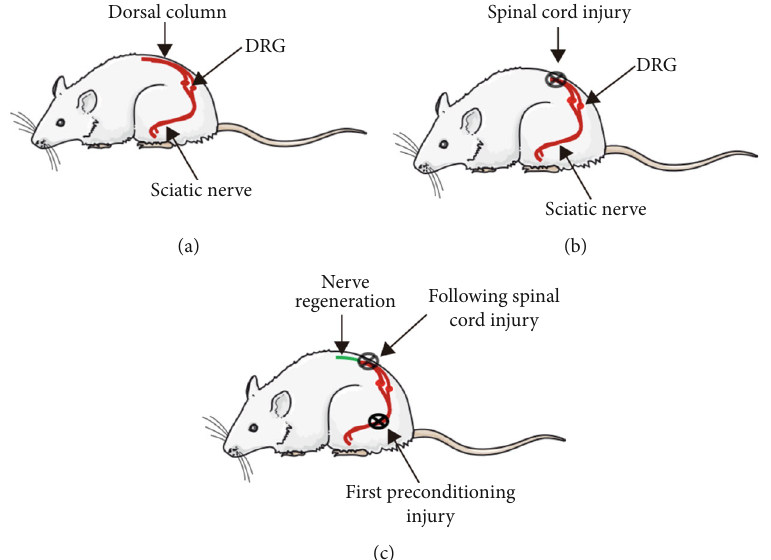
Figure 1: Preconditioning injury paradigm. (a) The DRGs are pseudounipolar neurons, dividing their axons into peripheral and central branches. The peripheral branches aggregate into the sciatic nerve to innervate sensory targets, and the central branches enter into the dorsal column and relay sensory information to the brain stem. (b) The central branch of DRG failed to regenerate after spinal cord injury. (c) A prior injury of the sciatic nerve could enhance the regrowth capacity of DRG to elicit regeneration of axons in the central nerve system following a subsequent spinal